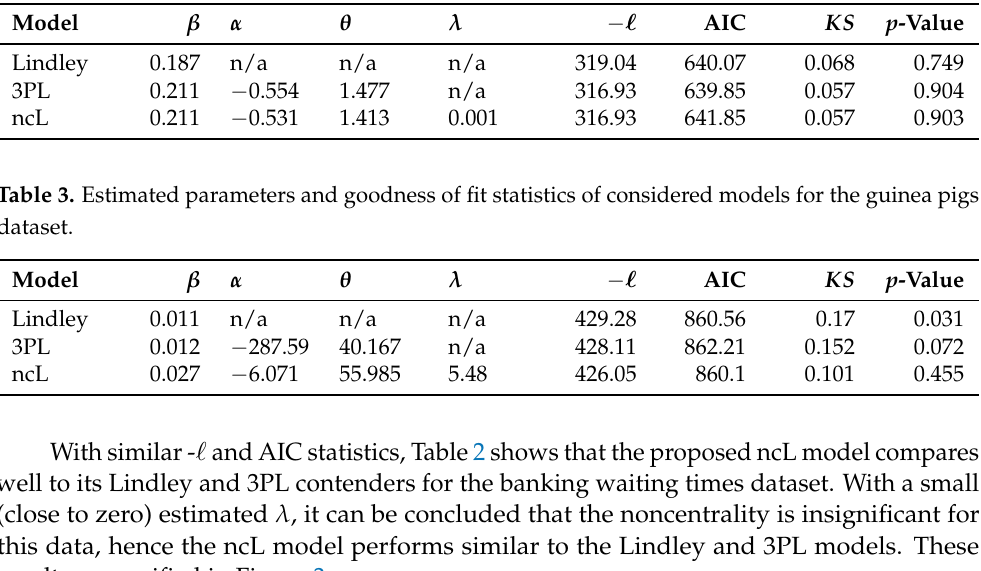
Table 2. Estimated parameters and goodness of fit statistics of considered models for the banking waiting times dataset.